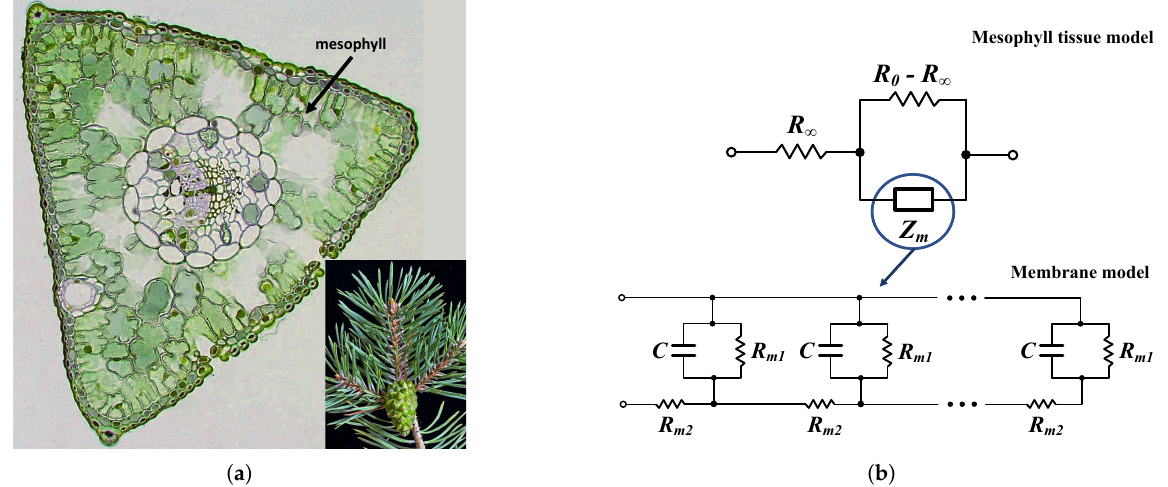
Figure 4. Scots Pine needles ( a ) cross section and ( b ) electrical equivalent circuit of the mesophyll cell.